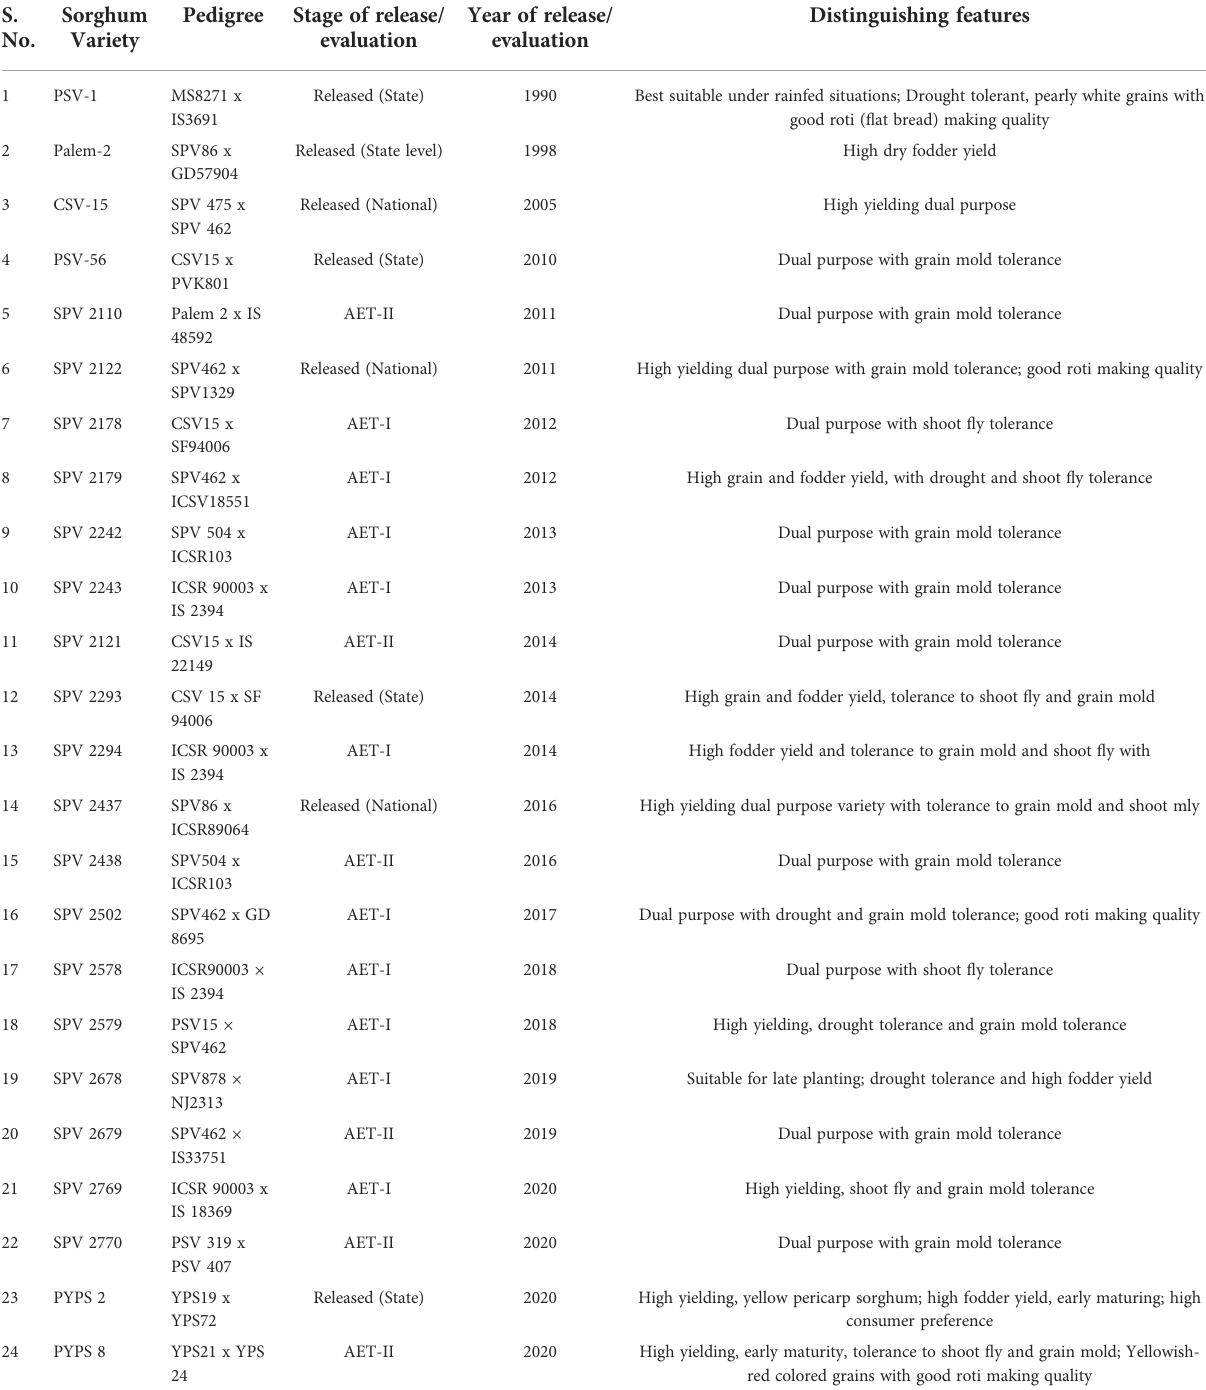
TABLE 1 Description of sorghum varieties included in the study. S.